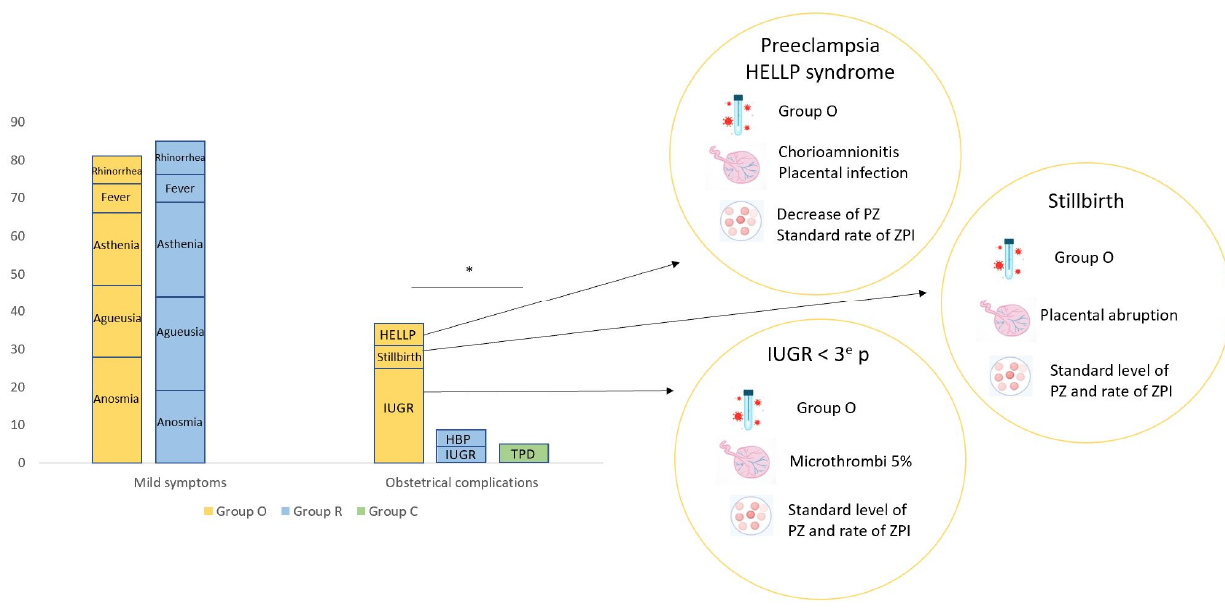
Figure 2. Clinical data of SARS-CoV-2 infection. HELLP: hemolysis, elevated liver enzymes, low platelet count; IUGR: intra uterine growth restriction; HBP: high blood pressure; TPD: threat of premature delivery, * p < 0.05.